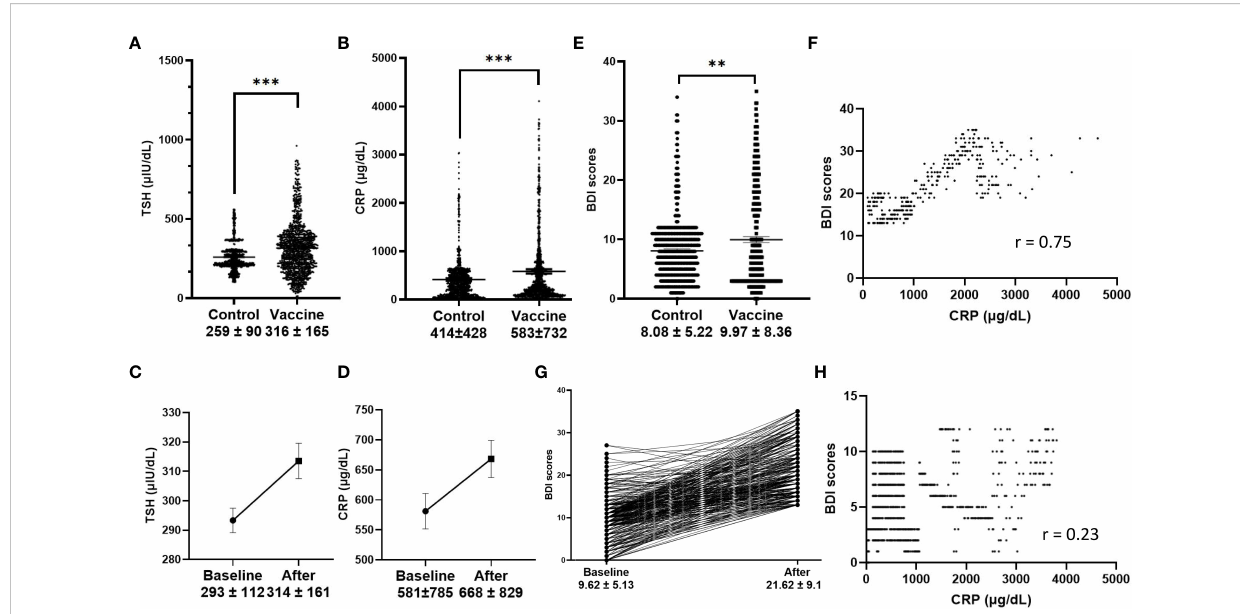
FIGURE 1 Serum markers and Beck Depression Index (BDI) scores. (A, B) , TSH and CRP values in the vaccine group and control group (p < 0.001 in matched analysis); (C, D) , TSH and CRP values before and after vaccination (p < 0.001); (E) , BDI scores in the vaccine group and control group, (p < 0.001 in matched analysis); (F) , CRP values were correlated with BDI scores after vaccination in the subgroup of patients with greater mood changes (de fi ned as BDI score > 13, r = 0.75), and no correlation was found in subgroup without greater mood changes (H) ; Changes of BDI scores before and after vaccination in the subgroup with greater mood changes (G)